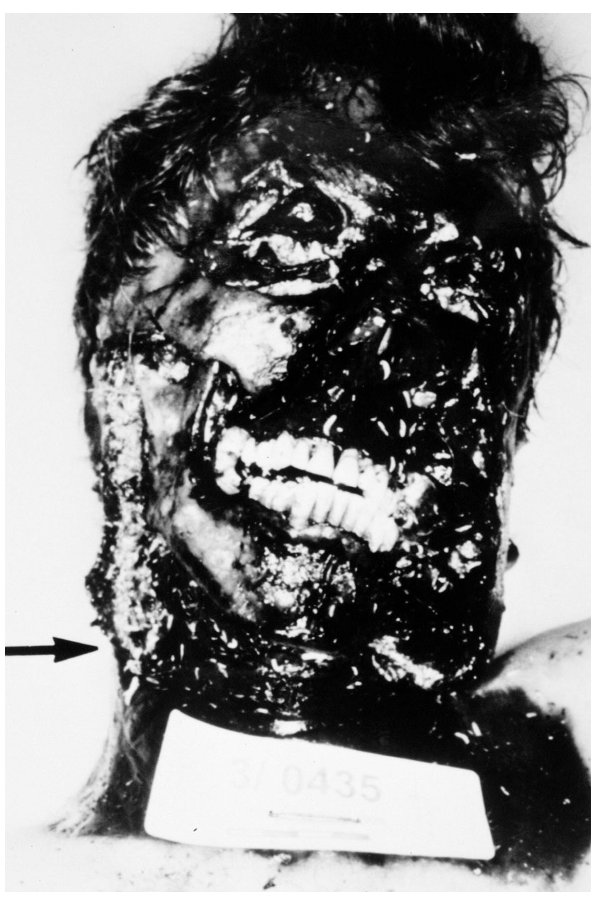
FIGURE 5 . The head of a decomposed corpse; the arrow indicates the gunshot wound.